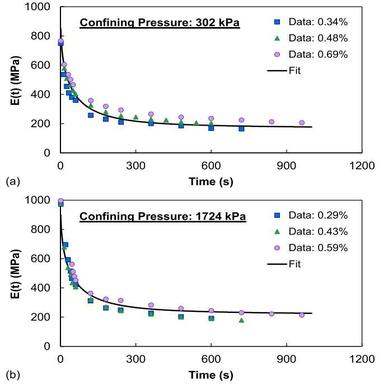
Model calibration using the triaxial relaxation data (at different confining levels.